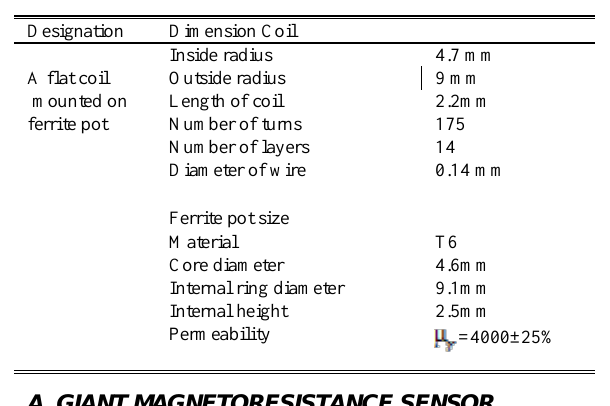
FIGURE 1. Inductive and giant magnetoresistance probes. TABLE I. Characteristics of the excitation coil